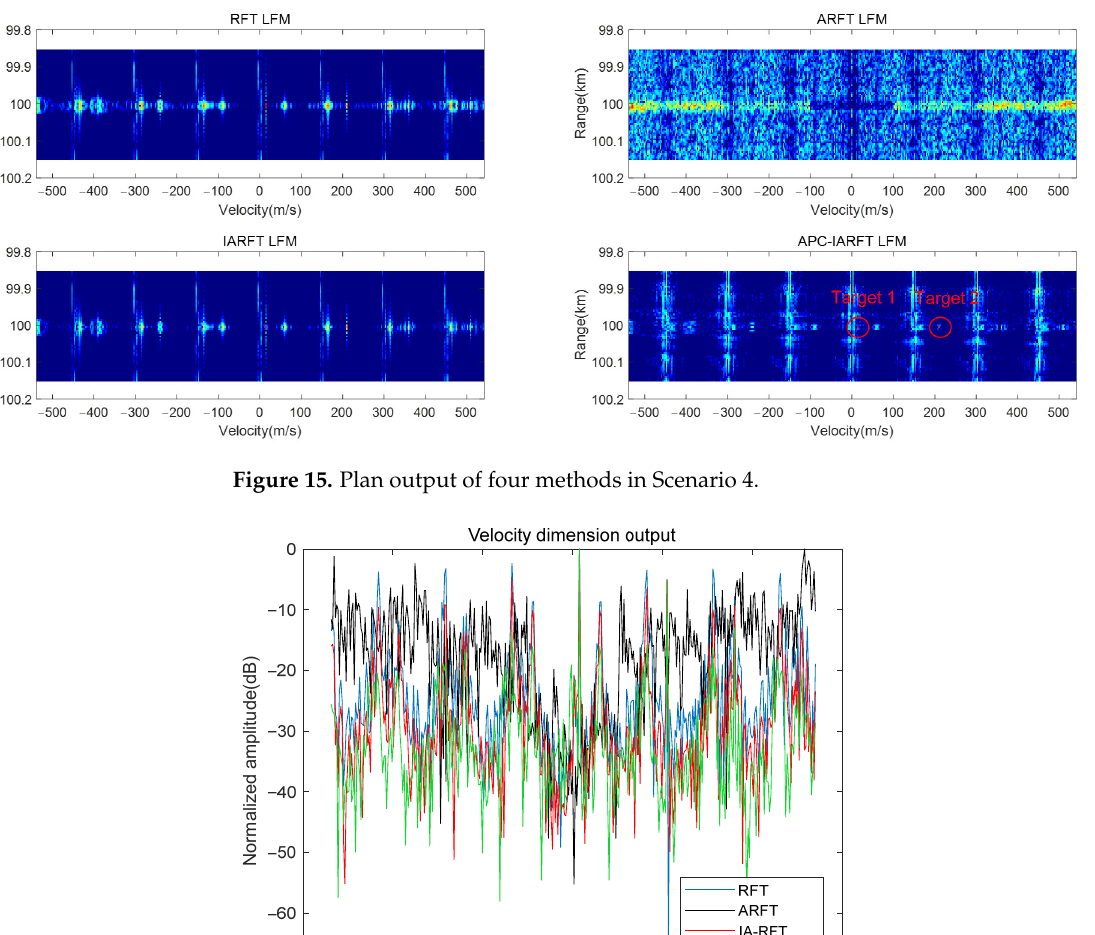
Figure 14. Stereogram output of four methods in Scenario 4. ( a ) Output of RFT; ( b ) Output of ARFT; ( c ) Output of IARFT; ( d ) Output of APC-IARFT.